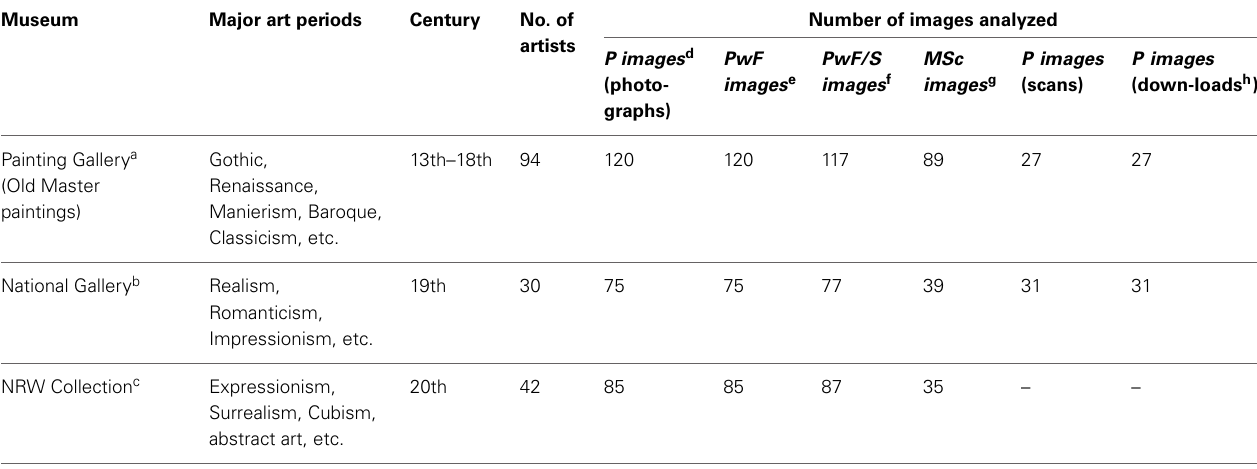
Table 2 | Description of museums, number of artists and number of images